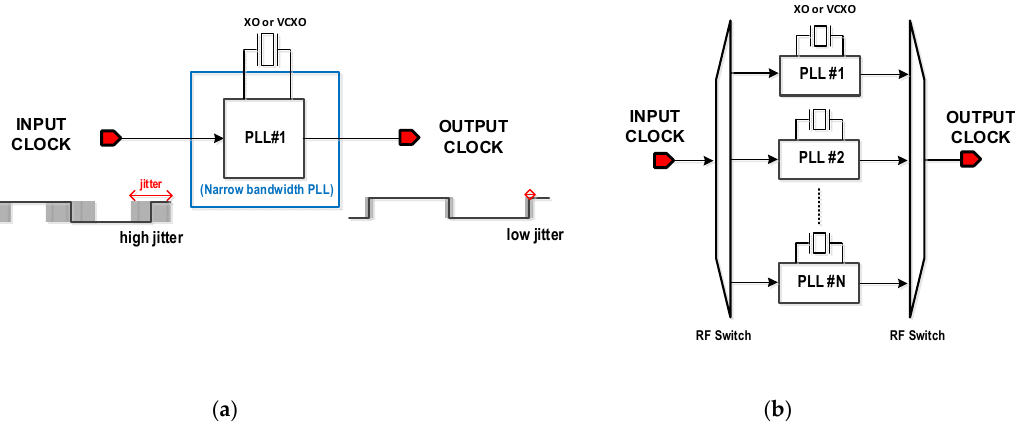
Figure 2. ( a ) Conventional PLL-based clock jitter attenuator. ( b ) Simplified block diagram of a wide-range jitter attenuator architecture using multiple PLLs.